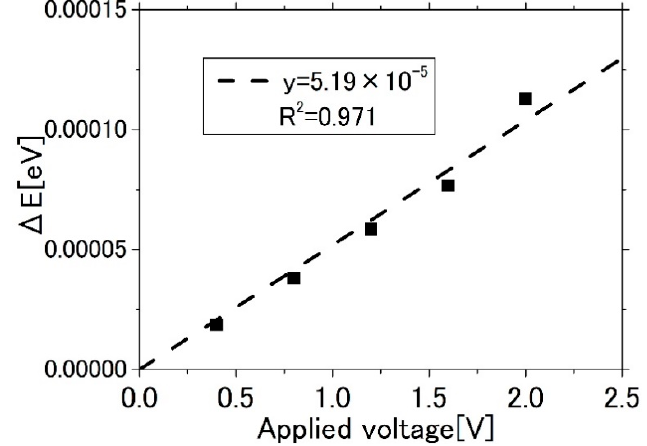
Figure 6. Dependence of Δ E on applied voltage at 222 Hz.